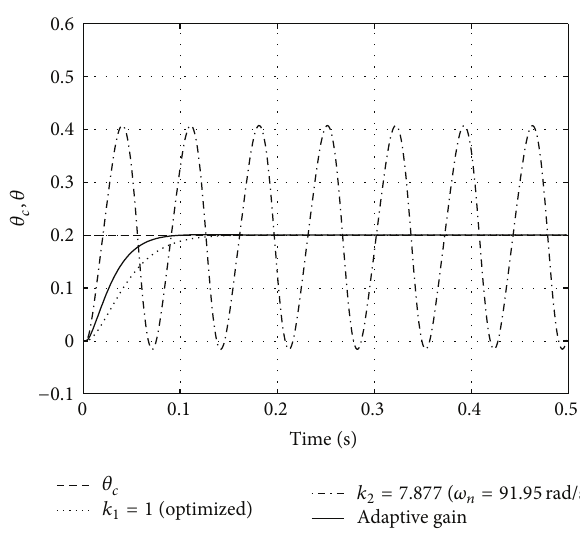
Figure 19: Time responses of velocity control system for low gain ( 𝐾 1 = 1 ) and high gain ( 𝐾 2 = 9.223 ) and adaptive gain.